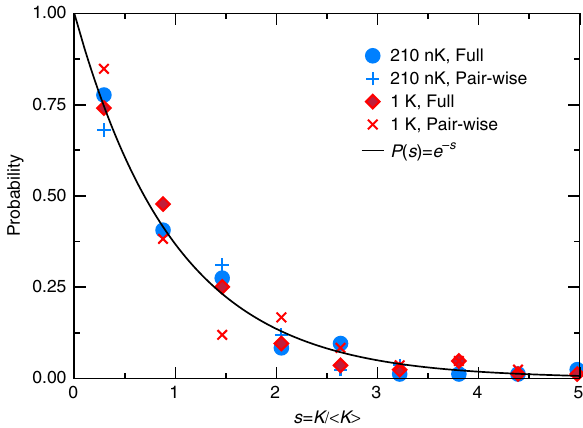
Figure 4 | Probability distribution of rotationally resolved rates. Distribution of the j 0 -resolved rate coefficient. Blue and red markers correspond to J ¼ 0 EQM data populating the v 0 ¼ 0, 1 and 2 of K 2 at initial collision energy E / k ¼ 210nK and 1K, respectively. Results for full and pairwise trimer potentials are shown by different markers. For each collision energy the rate coefficients are scaled to its mean value. The solid black curve is the Poisson